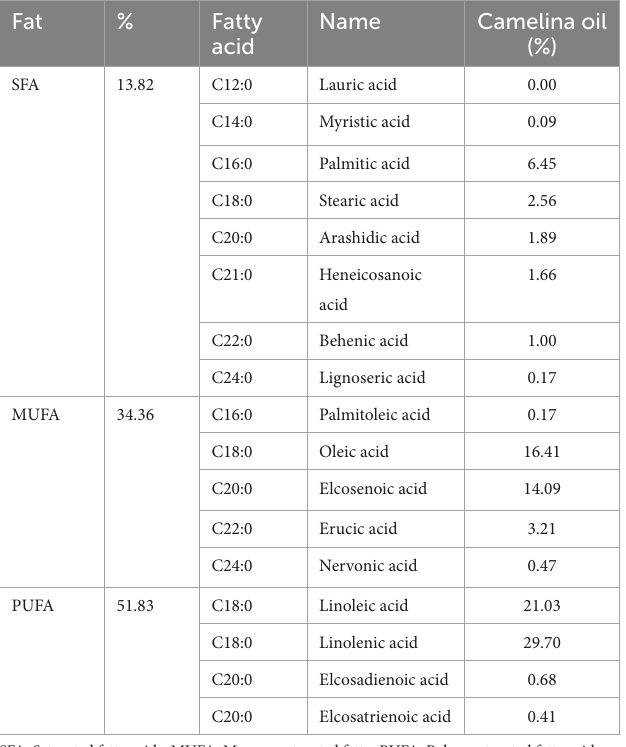
TABLE 1 Composition of fatty acids present in camelina sativa